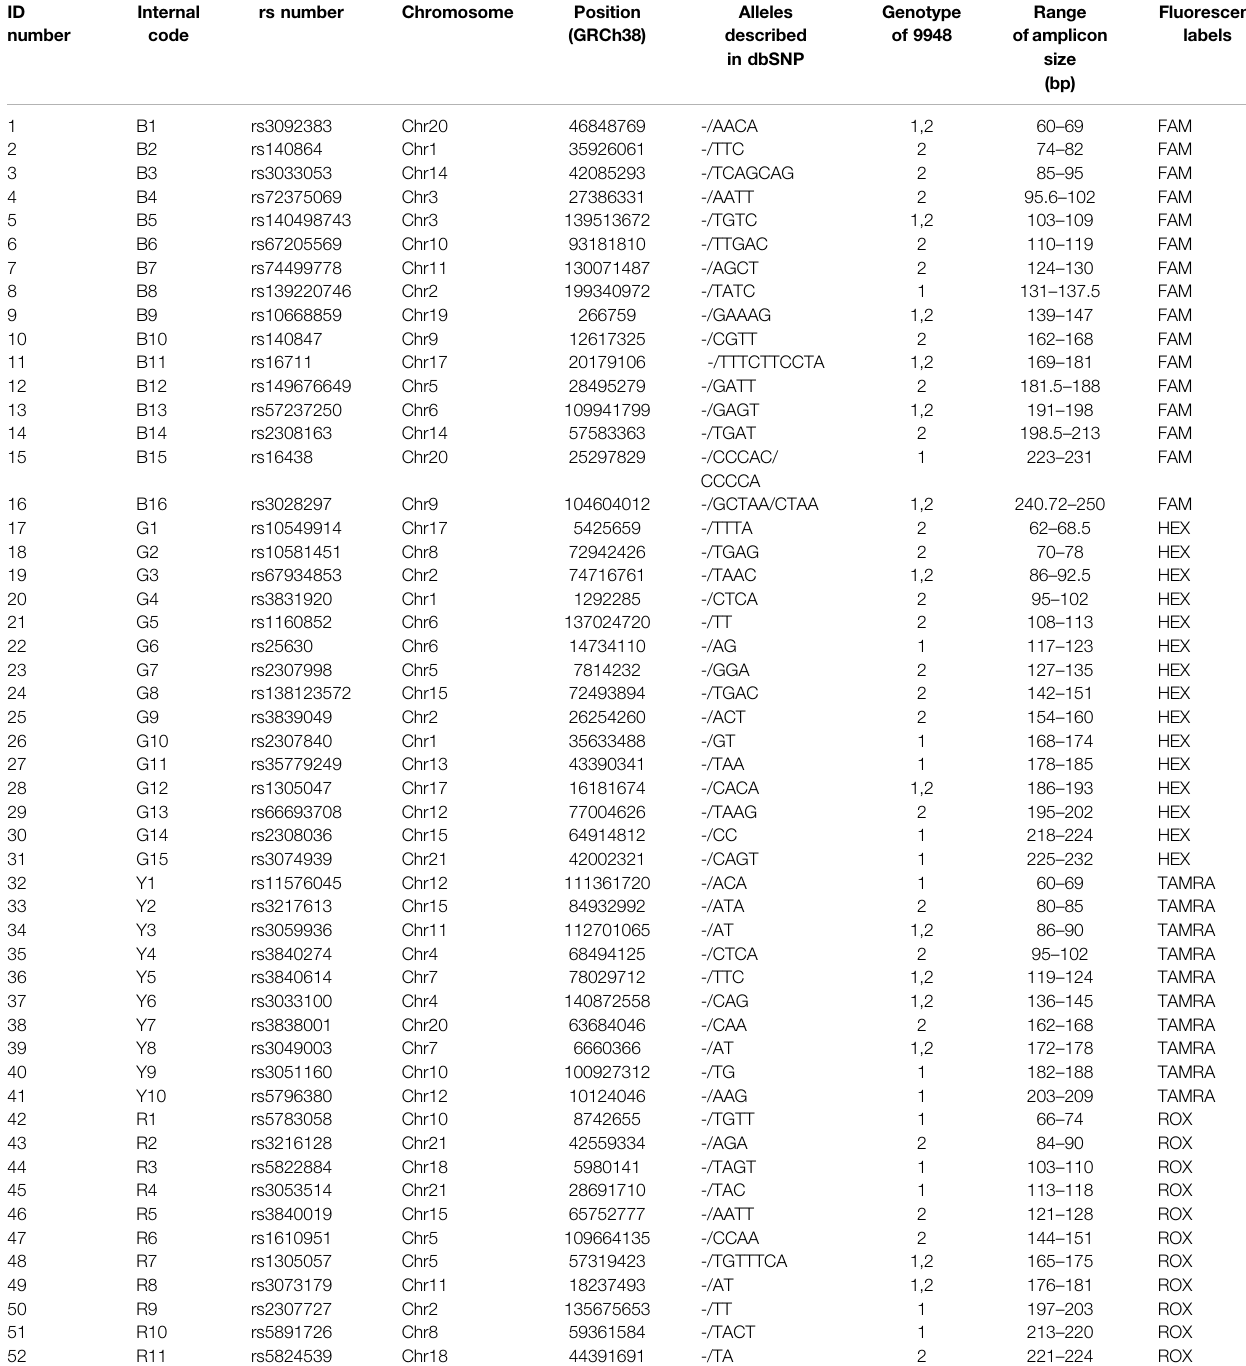
TABLE 1 | General information of the 52 AIDIP loci. The numbers 1 and 2 in the “ Genotype of 9948 ” column represent deletion and insertion of nucleotides,